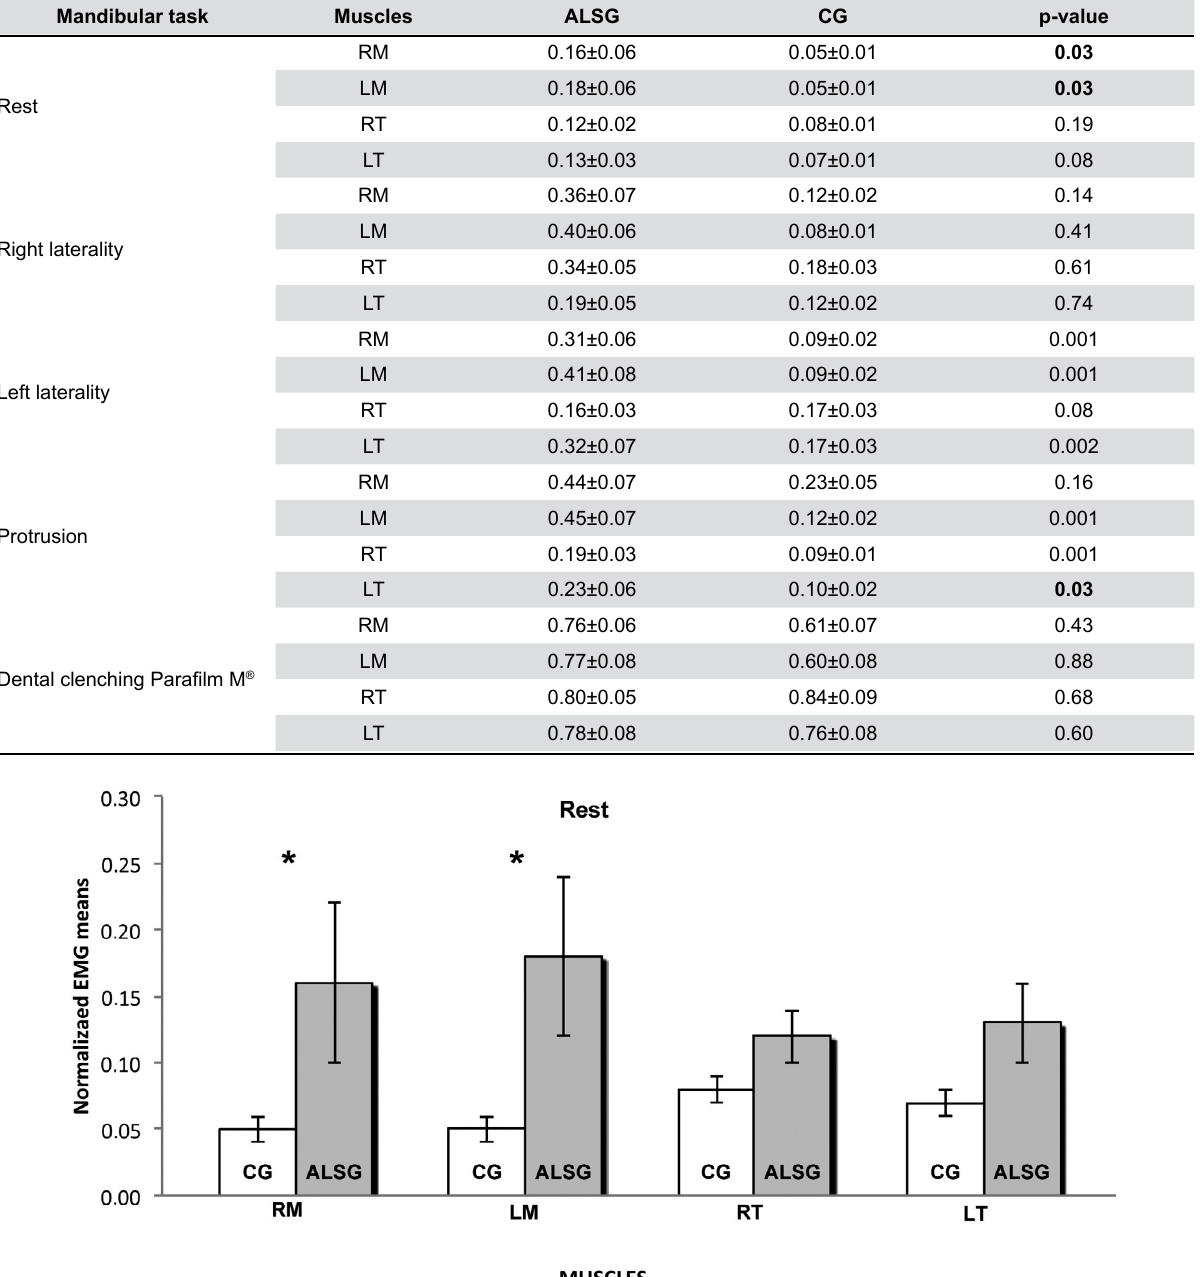
Figure 1- Normalized electromyography data of masseter (RM: right masseter; LM: left masseter) and temporalis (RT: right temporal; LT: left temporal) muscles for CG and ALSG in the rest. *statistically significant difference